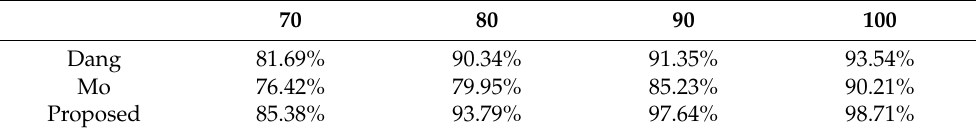
Table 6. Impact of different JPEG quality factor attacks on the